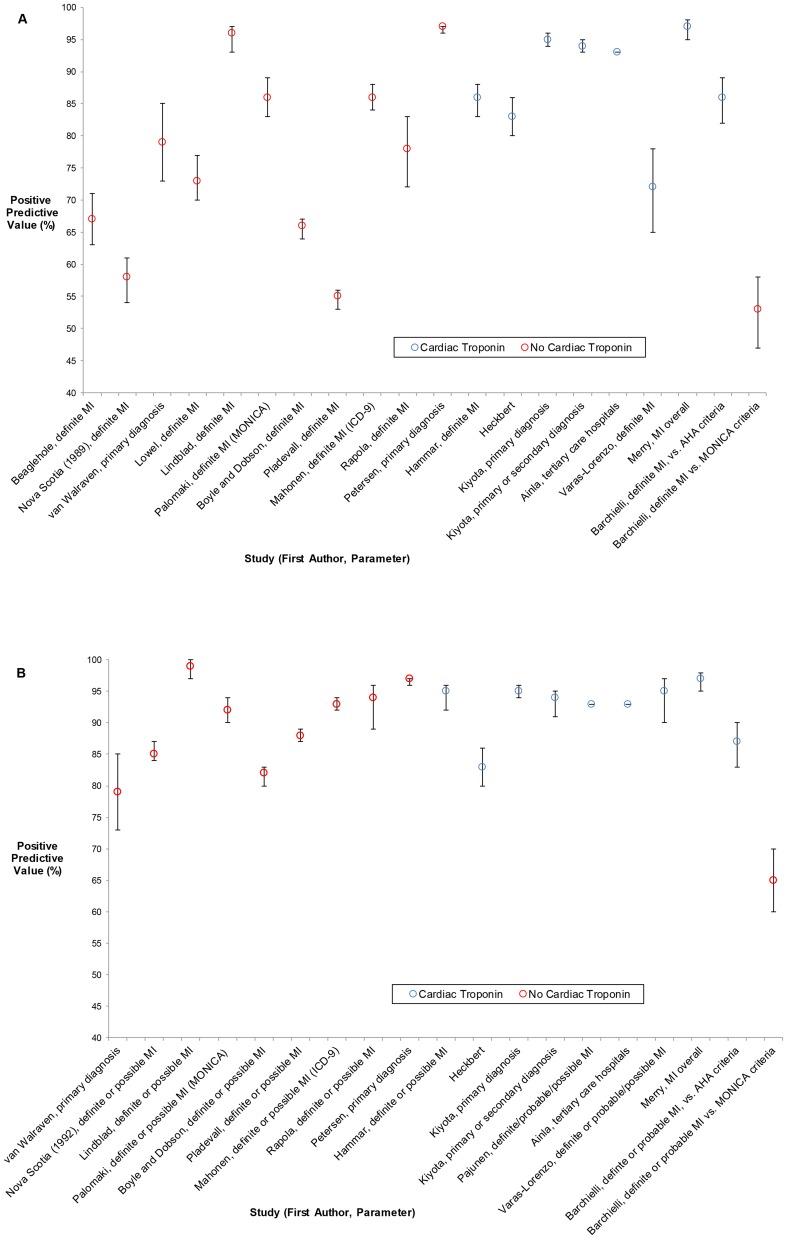
Positive Predictive Values of Myocardial Infarction Diagnoses (versus “Definite” or “Definite/Probable/Possible MI”, or parameters unspecified).The positive predictive values (PPV's) and 95% confidence intervals (where reported) from studies that validated myocardial infarction (MI) diagnoses in hospitalization data, and included a formal set of diagnostic criteria in the reference standard, are ordered left-to-right by publication year of the study (with the earliest-published study on the far left). The PPV's are also stratified by whether cardiac troponin testing was incorporated in the diagnostic criteria. Illustrated in Panel A are the PPV's calculated when the coded diagnoses were compared to the stricter parameter of “Definite MI”, and the PPV's for which no parameter was specified. Illustrated in Panel B are the PPV's calculated when the coded diagnoses were compared to the broader parameter of “Definite and Probable or Possible MI”, along with the same PPV's in Panel A for which no parameter was specified.